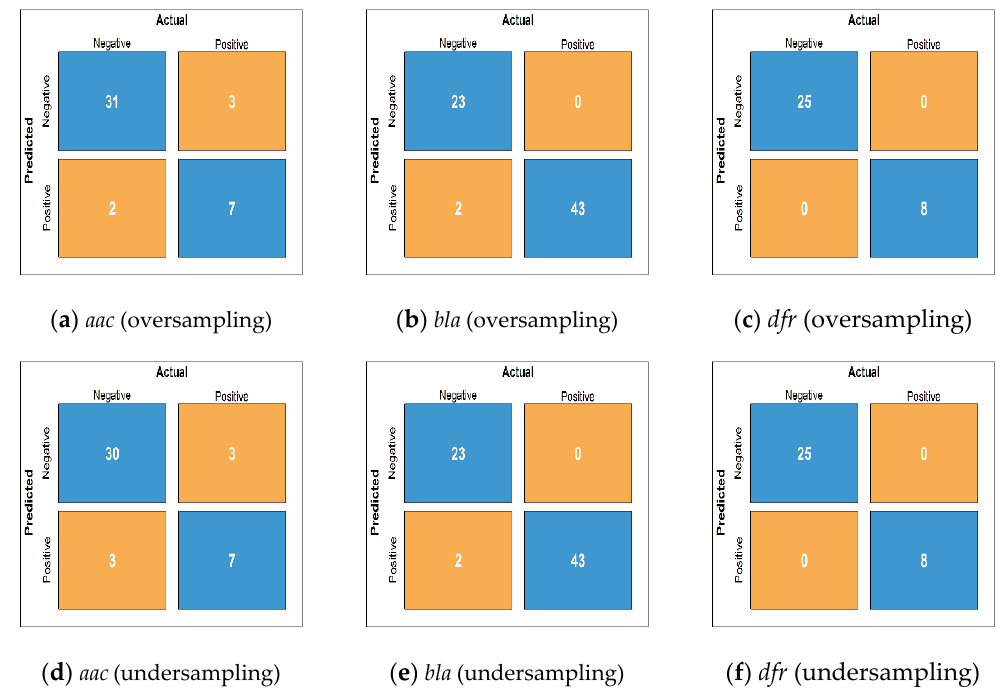
Figure 2. Confusion matrices obtained for the independent